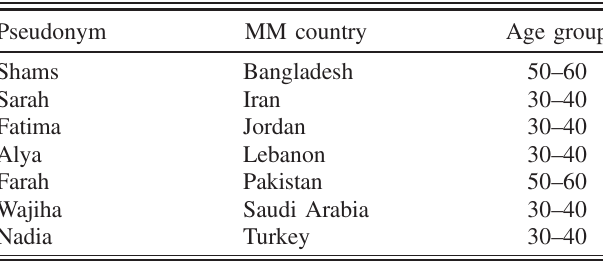
TABLE I. Participants, MM country in which they were trained, and their age